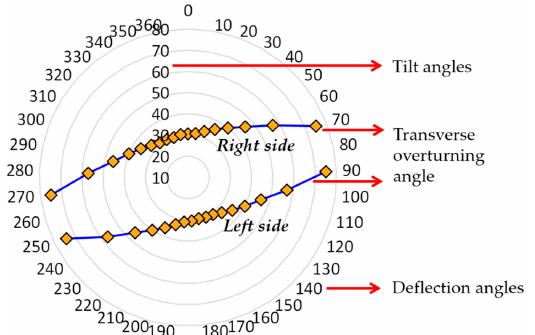
Figure 5. Results of the transverse lateral overturning with 10° increment of the deflection angle.